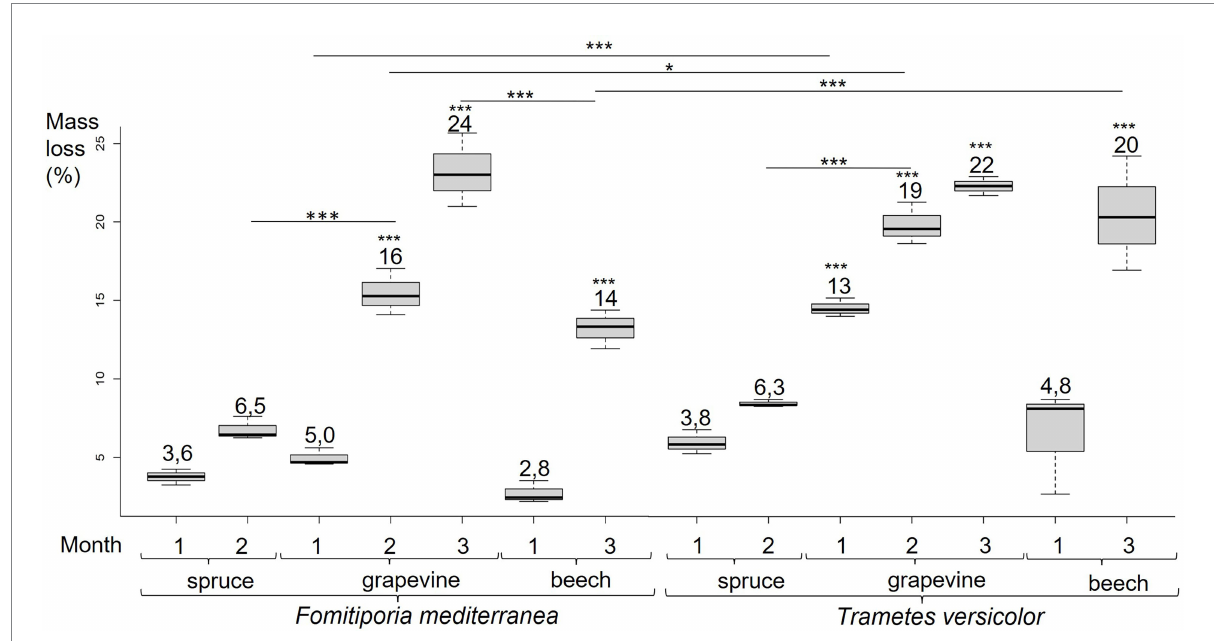
FIGURE 4 Fmed and Tver cultures mass loss on spruce at 1 and 2 months, grapevine at 1, 2 and 3 months, and beech at 1 and 3 months. Significant differences obtained with Conover-Iman test of multiple comparisons are indicated by *** for p -values < 0.001, ** for p -values < 0.005 and * for p -values <